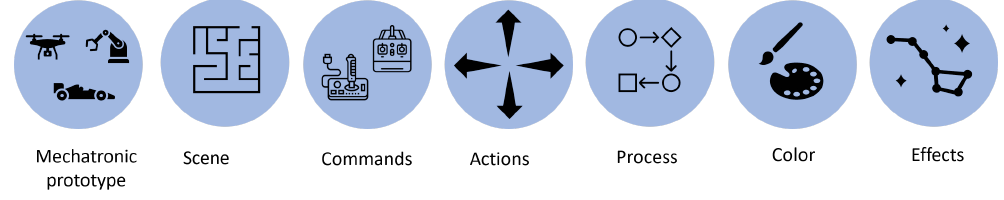
Figure 4. Storyboard